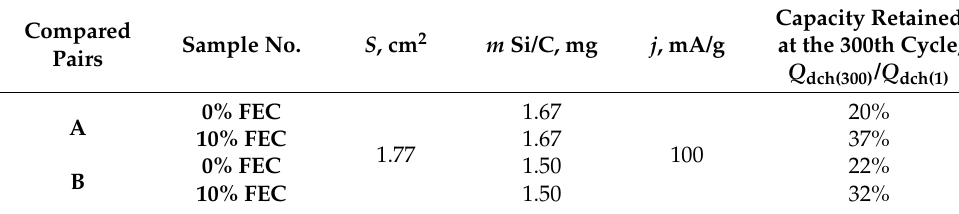
Table 1. Parameters of samples made by the “slurry” technology. Compared